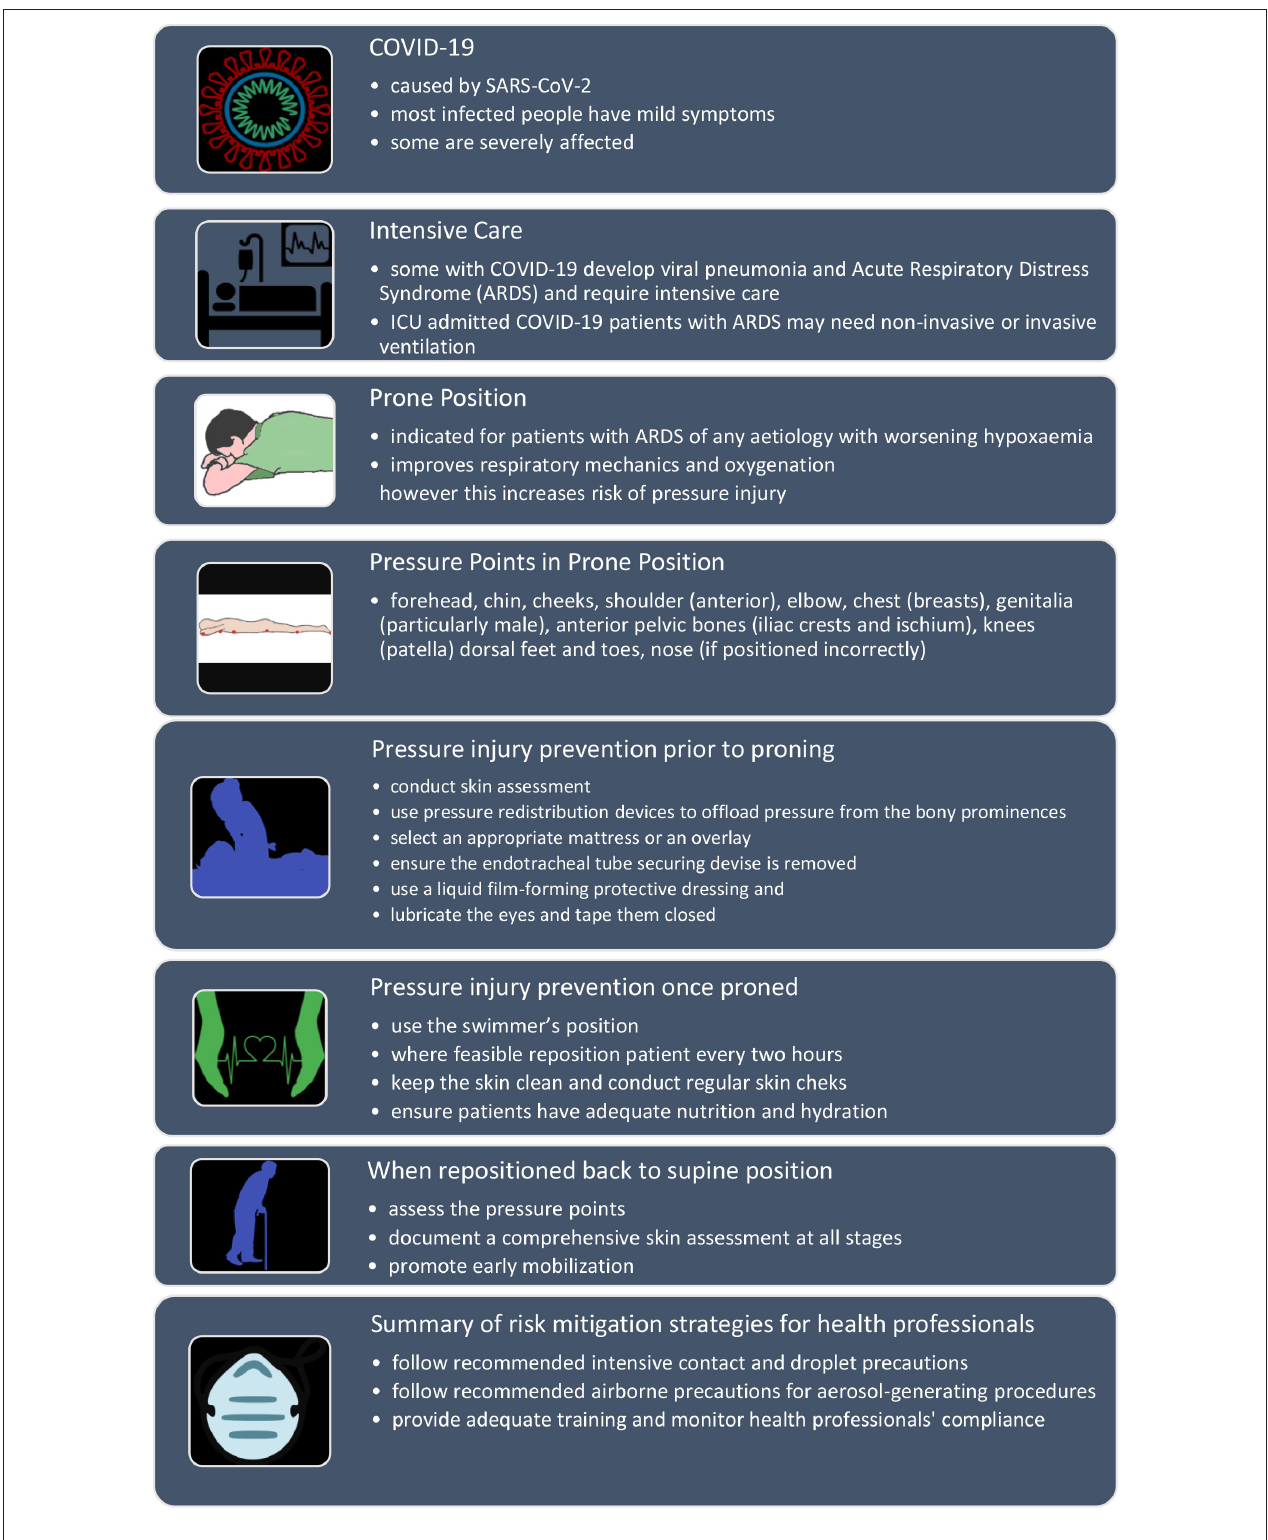
FIGURE 1 | COVID-19. Pressure Injury prevention in ARDS patients in prone position. Infographic.